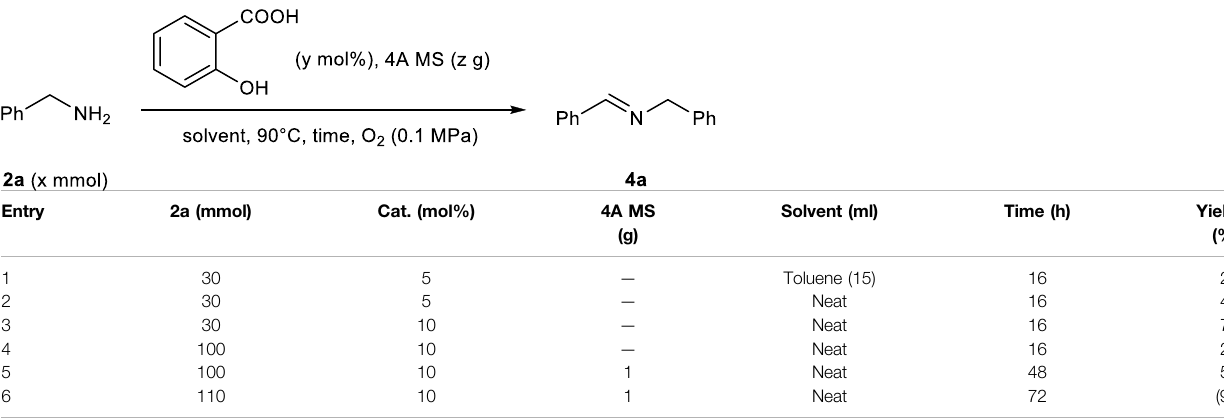
TABLE 3 | Optimization of multi-gram-scale synthesis of imines via the salicylic acid-catalyzed green oxidation of benzylamine.